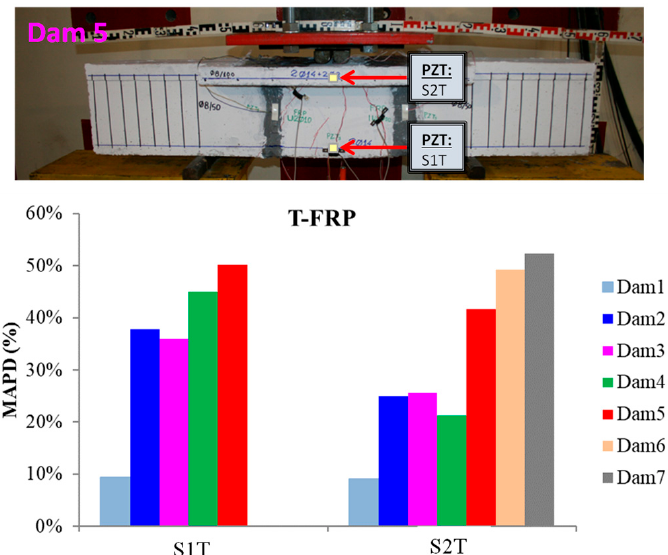
Figure 9. MAPD index values of PTZs mounted on the steel reinforcing bar of T-FRP.